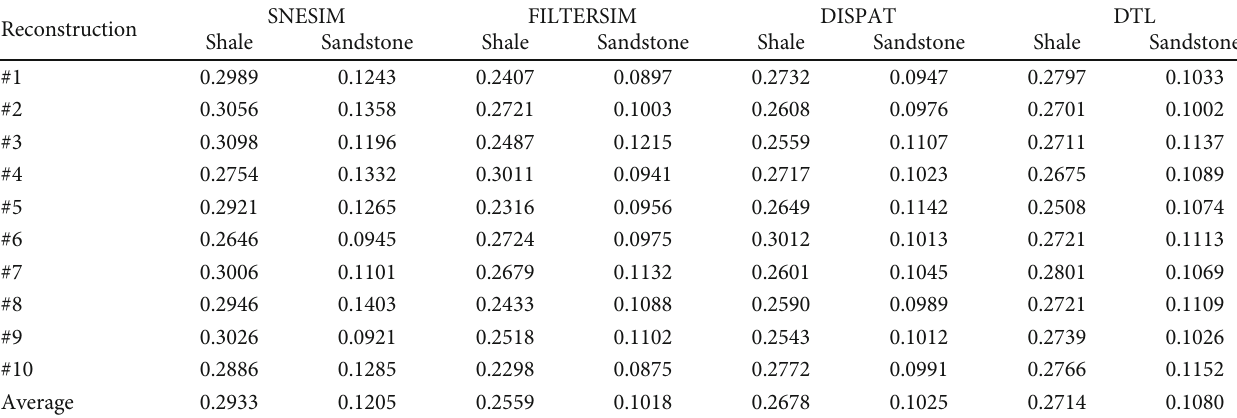
Table 2: Porosity of 10 reconstructed shale and sandstone images using SNESIM, FILTERSIM, DISPAT, and DTL.